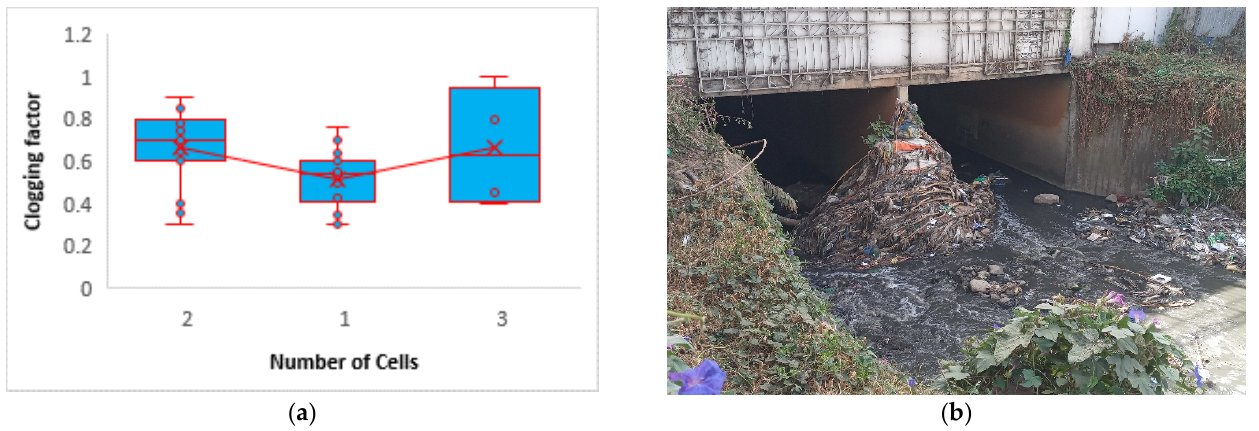
Figure 9. Relation of the number of cross-drainage cells with the solid waste clogging factor ( a ) and photo showing the impact of the intermediate barrel column on solid waste trapping ( b ).